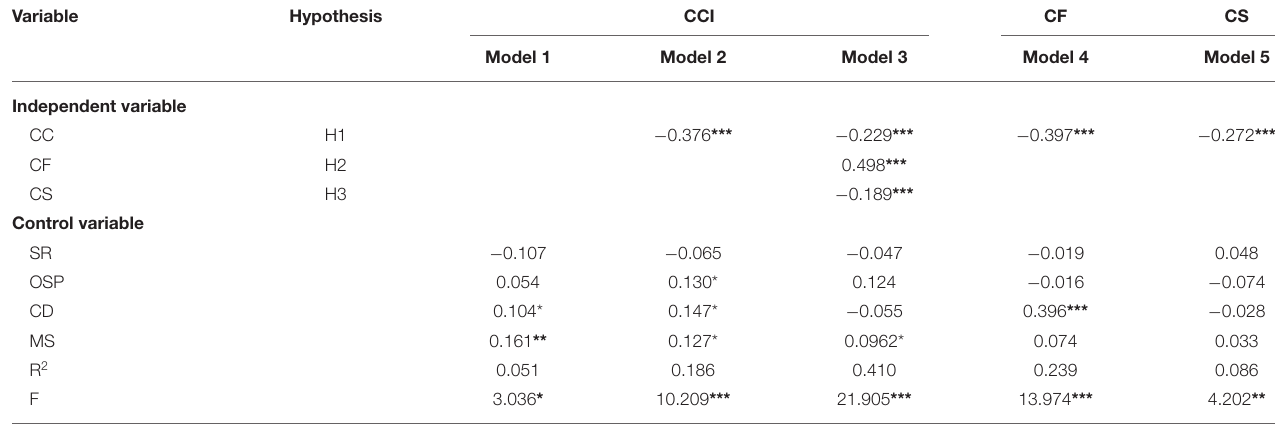
TABLE 4 | Regression analysis results.